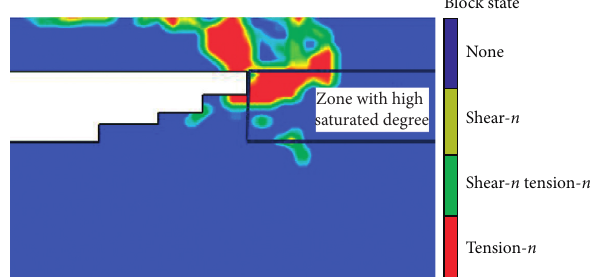
Figure 29: Distribution of plastic zone when excavation face ar- rives at the high saturated degree